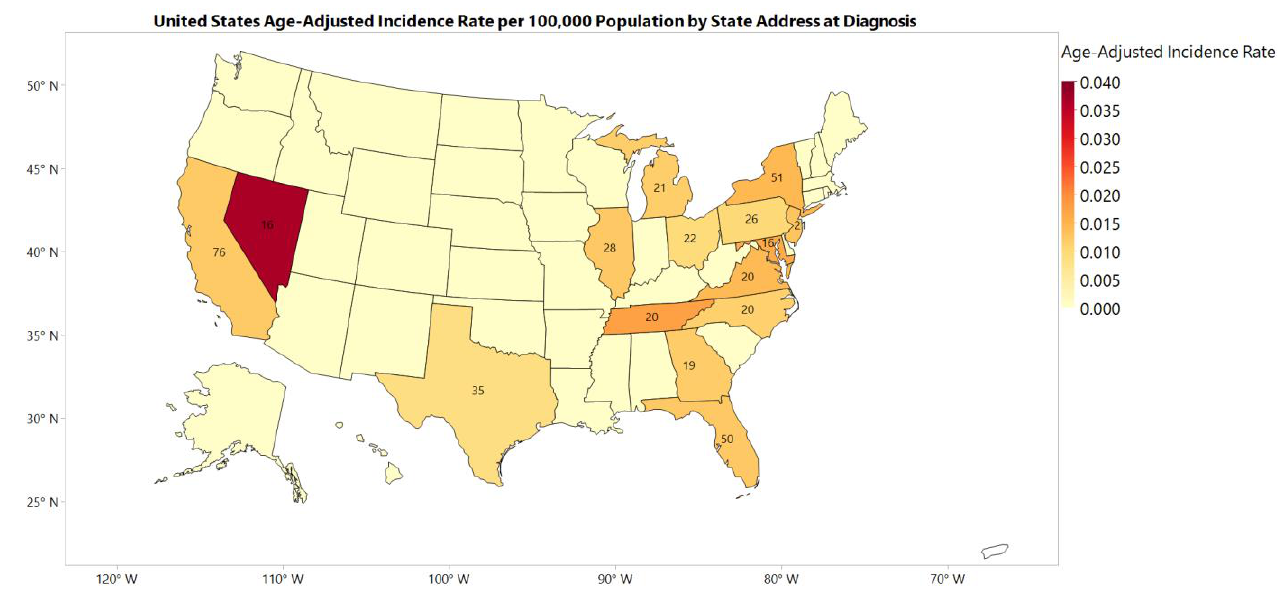
Figure 4. A map of the United States of America shows the state address at diagnosis of mixed pancreatic endocrine and exocrine tumor, malignancy, and patients colored by the age-adjusted incidence rate per 100,000 for each state between 2001 and 2017. The number inside each state represents the actual number of cases during the same duration. States colored with light yellow and without numbers in the map have a count number of less than 16 cases during the same period and the age-adjusted incidence rate for these states has not been calculated. One United States territory, Puerto Rico, has no colors because of a lack of information.